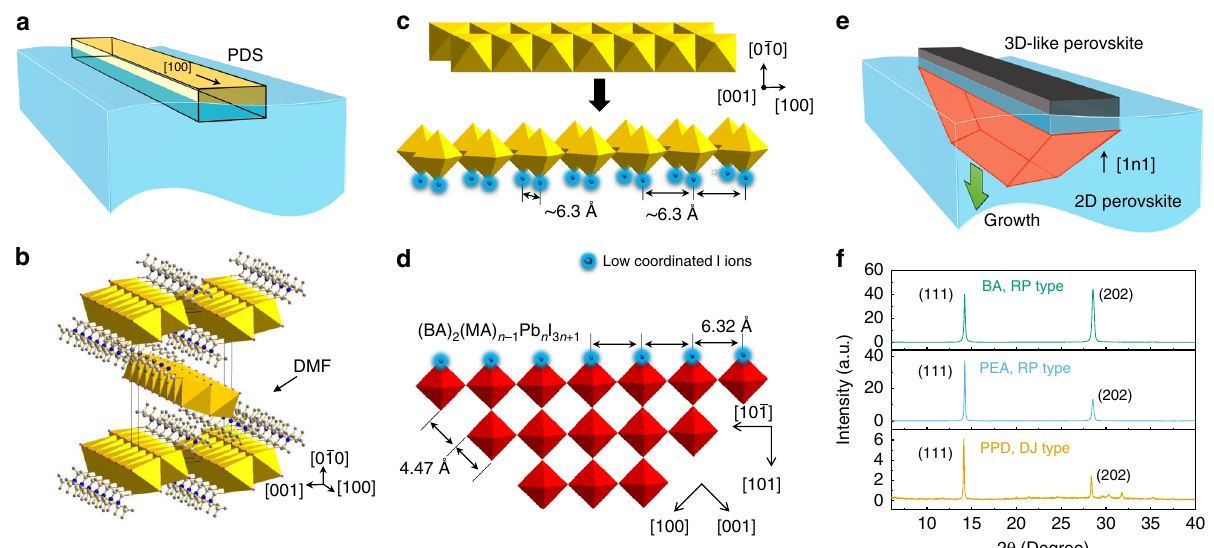
Fig. 4 Lattice-matching de fi ned crystal orientation. a Illustration of the one-dimensional PDS crystals lying on solution surface; b the edge-sharing Pb-I octahedra chains in one-dimensional PDS crystal. c Illustration of the conversion of edge-sharing Pb-I octahedra chains into corner-sharing octahedral chains (see detailed process in supplementary movie 1), in which the I − ions at the exposed corners are low-coordinated I - ions (blue colored). d Illustration of the corner-sharing PbI 6 octahedra in the (0 1 0) plane of RP perovskites and the low-coordinated I − ions (blue colored) at the edge of crystal sheet along the ½ 10 (cid:1) 1 (cid:2) direction. e Illustration of the templated downward growing layered perovskite crystals on 3D-like perovskites, in which the dominating orientation is de fi ned by the lattice matching shown in ( c ) and ( d ). f XRD spectra of BA-based RP perovskite fi lm (< n > = 4), PEA-based RP perovskite fi lm (< n > = 4), and PPD-based DJ perovskite fi lm (< n > = 4) with OP orientation, in which the dominating diffraction peaks are all (1 1 1) and (2 0 2)